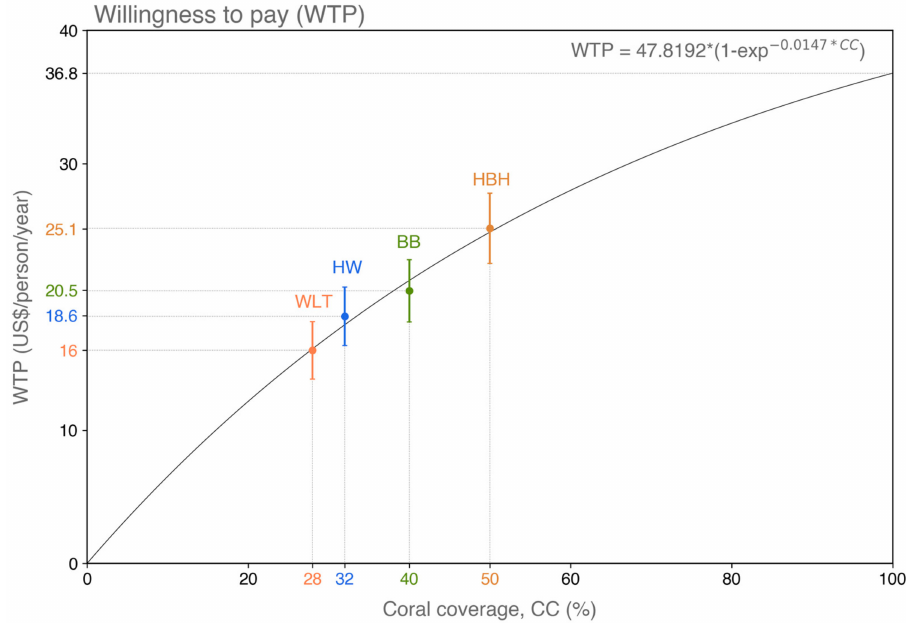
Figure 4. Willingness to pay as a function of coral coverage (US$ / person / year).WLT: Wanlitong, HW: Houwan, BB: Banana Bay and HBH: